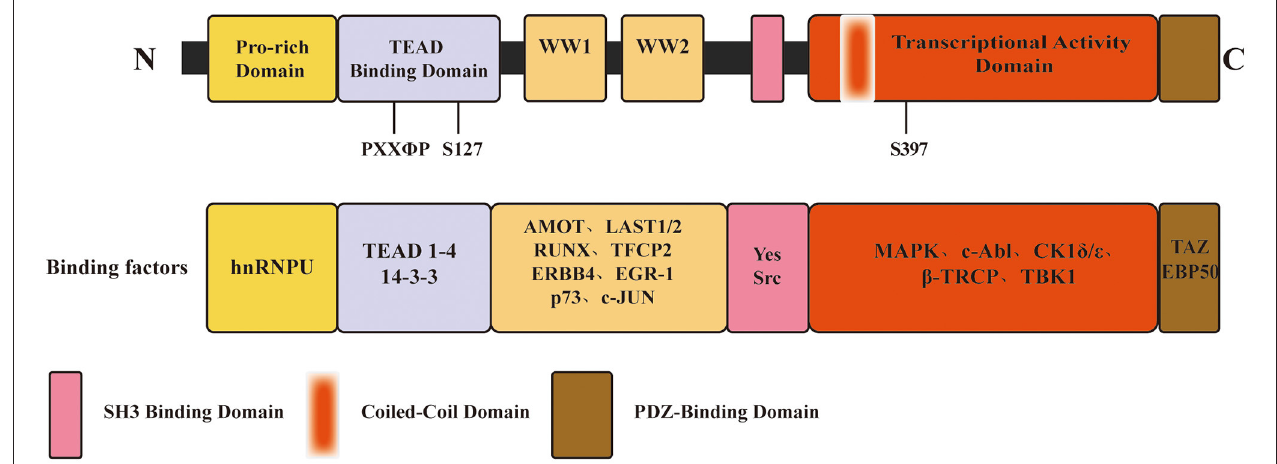
FIGURE 1 | Schematic of YAP domain architecture, major binding sites and factors. From N-terminus to C-terminus, YAP contains a proline-rich domain, a TEAD-binding domain, one or two WW domains, an SH3-binding domain, a coiled-coil domain, a transcription activation domain, and a C-terminal PDZ-binding domain. The PXX 8 P motif in the TEAD binding domain is important for the interaction between YAP and TEAD 1-4. S127, S397 , primary phosphorylation sites by LATS1/2, which is a major modulation of YAP